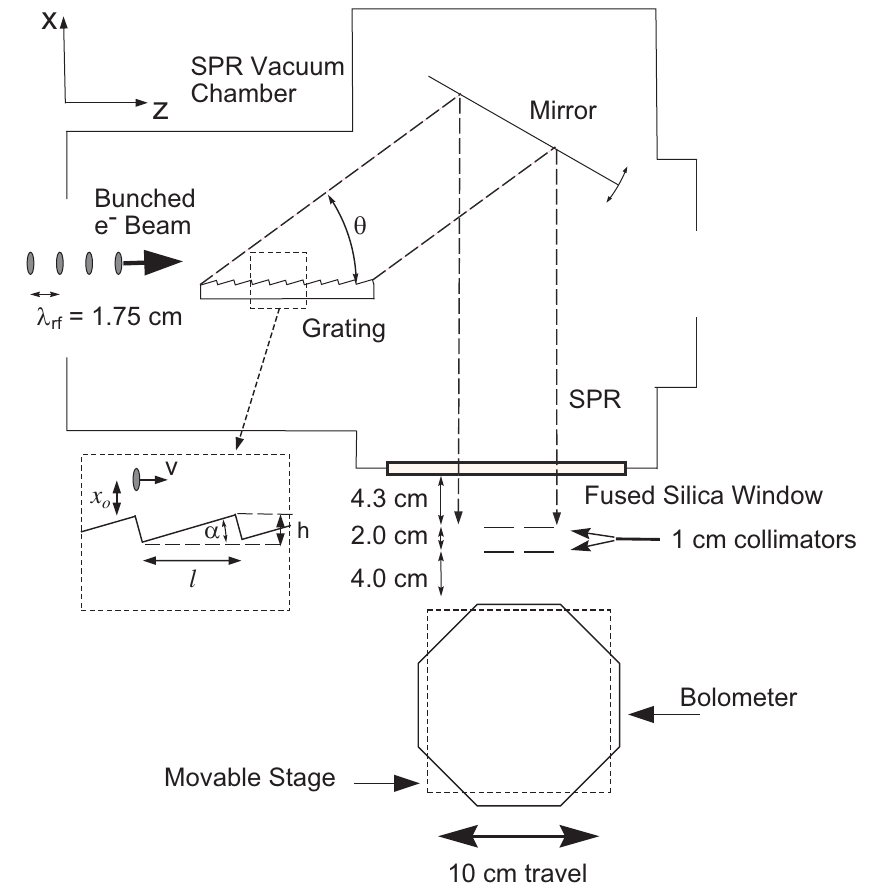
FIG. 1. SPR experimental setup. The train of bunched electrons is traveling along the z direction above a metallic echelle grating. The diffracted radiation is measured by a detector located outside of the vacuum